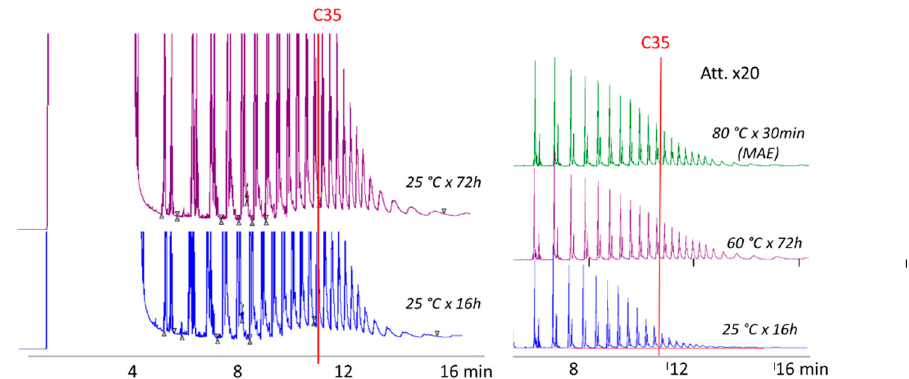
Figure 1. Optimization of polyolefin oligomeric hydrocarbons (POH) extraction from polypropylene (PP) containers.